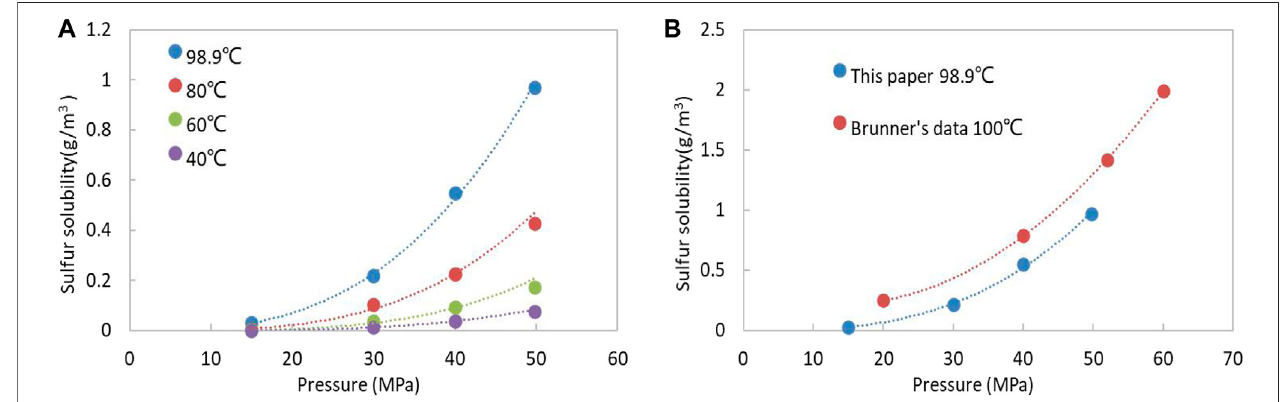
FIGURE 2 | Sulfur solubility in well M1 gas sample. (A) experimental results in this work; (B) comparison with Brunner ’ s data at similar gas compositions. The sour gas in Brunner ’ s data contains 20 % H 2 S, 66 % CH 4 , 10 % CO 2 , and 4 % N 2 .